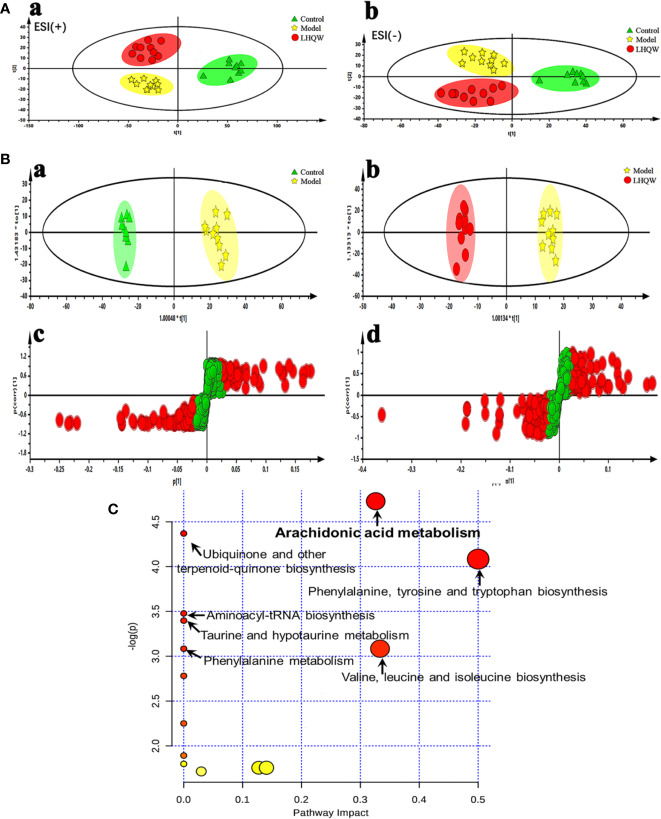
Serum metabolomics analysis of changes in metabolic profiles among control, model and high dose of LHQW groups. Mice were randomly divided into three groups: control group, model group and high dose LHQW group (1,300 mg/kg/day) (n = 10). Model and LHQW groups were infected with H1N1 (2 × LD50 per mouse) 2 h after the first administration and intragastrically administered twice per day (8-hour interval) for five consecutive days. The blood was taken from eyeball after the last oral administration 2 h later, and centrifuged subsequently to obtain supernatant for use. (A) PCA scores plot of comparing control, model and LHQW groups in positive ESI modes (a) and negative ESI modes (b). (B) The OPLS-DA score plots and S-plots generated from the OPLS-DA of the QTOF/MS data from control, model and LHQW groups in the ESI− mode. OPLS-DA score plots were the pair-wise comparisons between the control and the model (a) as well as the model and LHQW (b). S-plot of the OPLS-DA model was for the control and the model (c) and the model and LHQW (d), whose axes plotted in the S-plot from the predictive component are p1 vs. p(corr)1, representing the magnitude (modeled covariation) and reliability (modeled correlation) respectively. (C) Summary of pathway analysis with MetaboAnalyst 3.0 based on the differential metabolites.